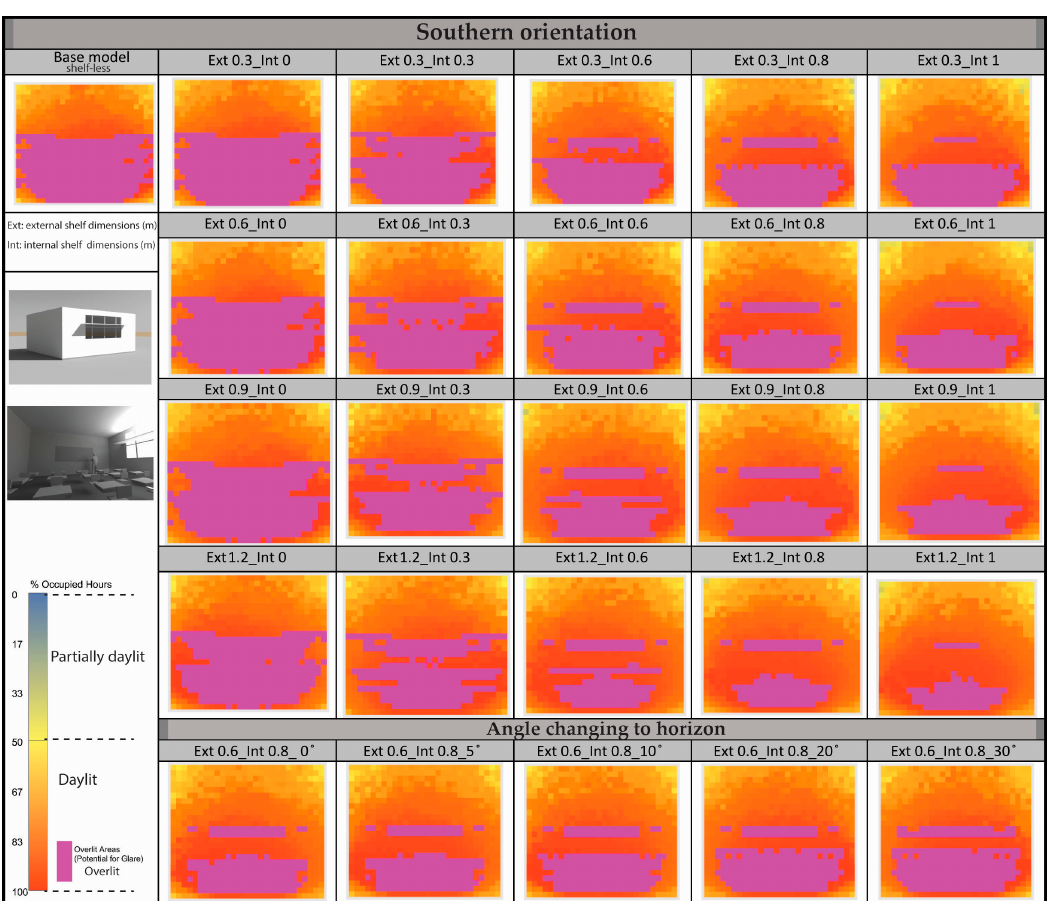
Figure 2. The results of daylight availability analysis for light shelf southern orientation in the three mentioned intervals and the colored degree format on the work plane surface.